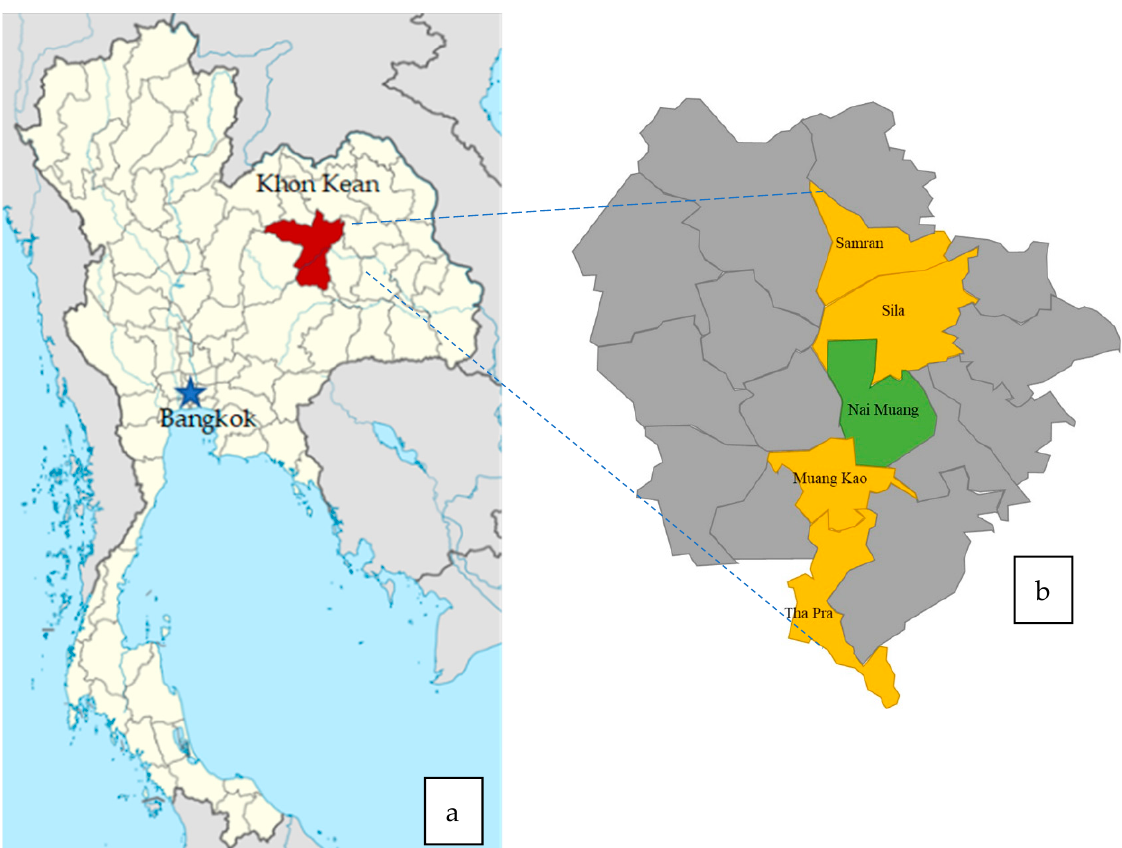
Figure 5. Study area: Khon Kaen, Thailand (NordNordWest 2009); ( a ) indicates Khon Kaen province, located in northeast Thailand; ( b ) indicates the Muang District with five municipalities included in this study, classified with green for urban characteristics and orange for peri ‐ urban characteristics.